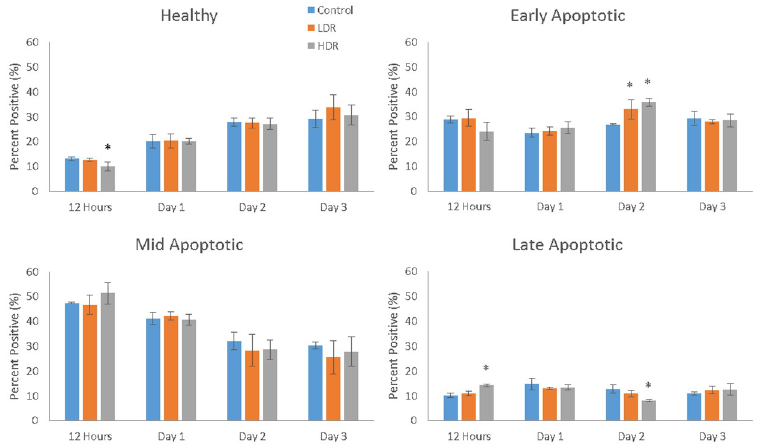
Fig 4. Cell distribution within the various stages of apoptosis as measure by mitochondrial membrane depolarization ( � = p < 0.05 when compared to the control for the same time point). N = 3 independent experiments each with 2000 cells that analyzed for each time point and